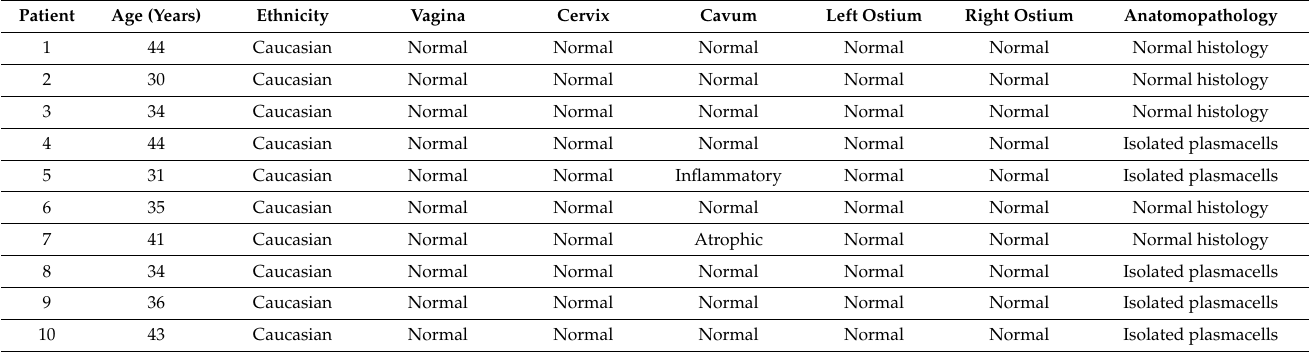
Table 1. Clinical data from the 10 patients enrolled in the study. Observations of the vagina, cervix, cavum, and ostium were documented in the context of their fertility trajectory. From every patient, a biopsy of the endometrium was analyzed in the laboratory of anatomopathology for the presence of plasma cells indicating